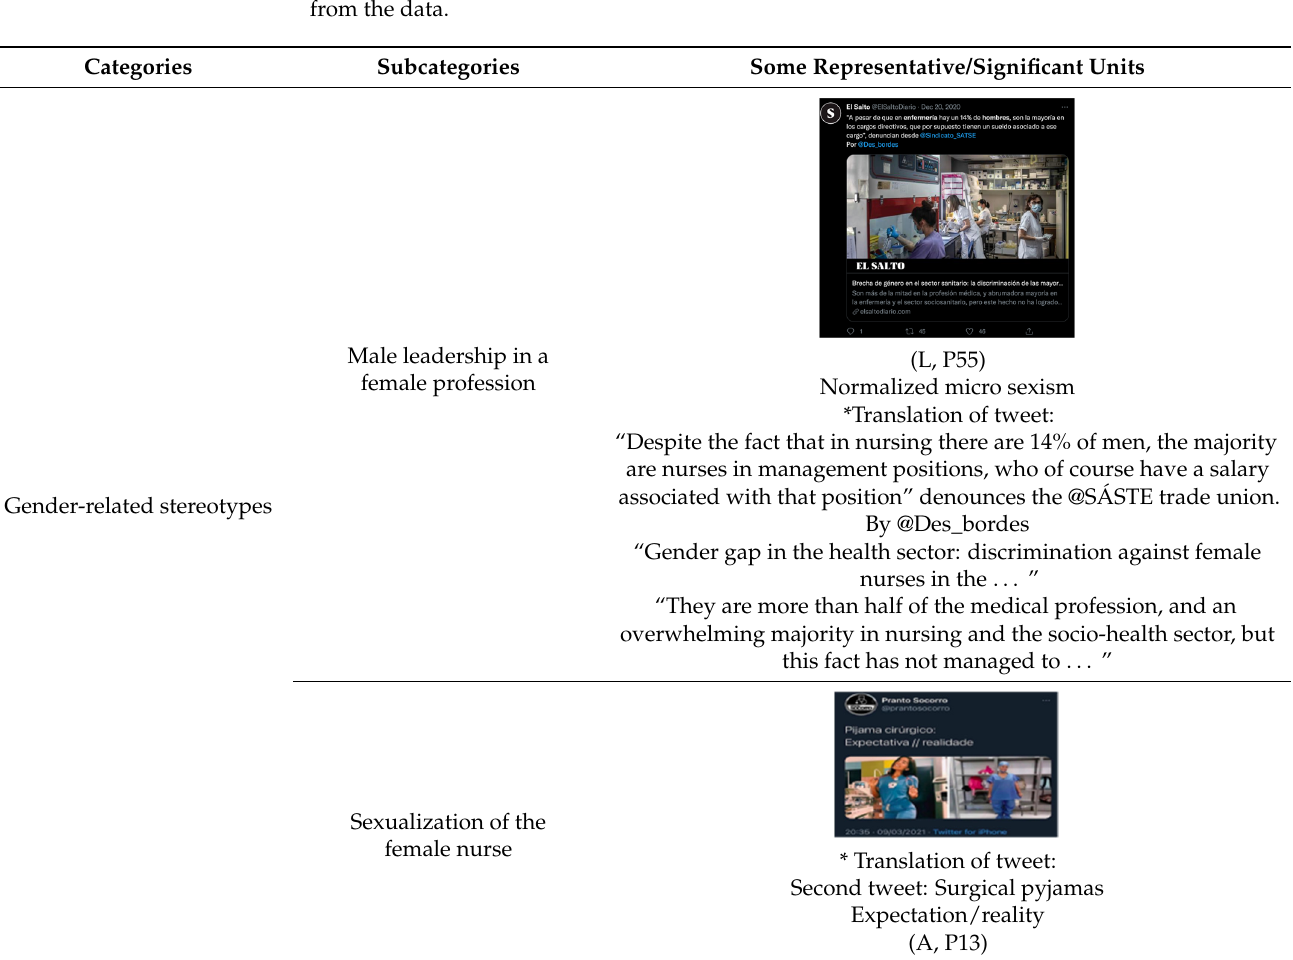
Figure 1. Matrix “Healthcare professionals and COVID”. Table 2. Categories, subcategories, and representative photographs/significant units highlighted from the data.